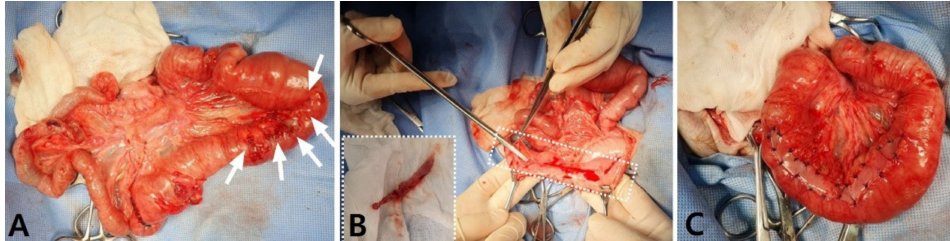
Figure 3. Intraoperative photographs representing the damaged serosal surface of the jejunum after adhesiolysis in a dog. ( A ) The proximal jejunum, which was released after adhesiolysis, represents the damaged serosal surface of approximately 7 cm in length (white arrows). ( B ) A parietal peritoneum (8 × 1.5 cm rectangular shape) was harvested from the left side of the abdominal wall. ( C ) The excised peritoneal graft was attached to the injured serosal surface with simple interrupted sutures to cover the entire damaged